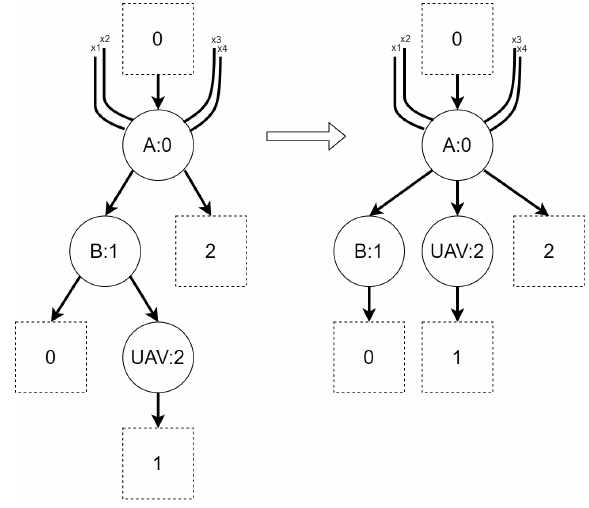
Figure 10. Reaction rule move out of base for scenario 2. Rationale: the rule allows to move a UAV out of base. 4. The download data reaction rule: